Question: Draft a figure caption describing what is shown.
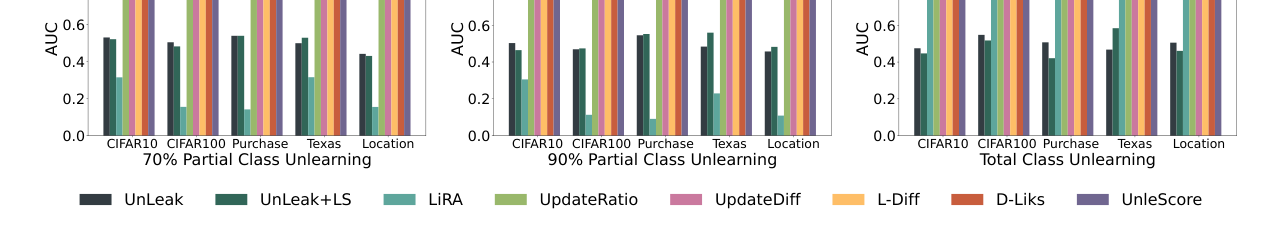
Answer: presents the summarized AUC scores for all metrics across three exact unlearning tasks applied to five datasets. Al- though LiRA, UpdateRatio, and UpdateDiff seem comparable to our designed metrics, they exhibit distinctly different score distribu- tions, as illustrated in Figure 5, and different results at lower FPR, as shown in Figure 10 and 11. Consequently, we do not regard the AUC as a meaningful statistic for evaluating these measurement results. For random sample unlearning, we further analyze TPR varia- tions as the FPR shifts from 1e-5 to 1e-1, as shown in Figure 12. On a logarithmic scale, L-Diff and D-Liks significantly outperform other baselines, particularly at lower FPRs, with minor differences between each other. Besides, the ROC curves for LiRA, UpdateRatio, and UpdateDiff align with those of L-Diff and D-Liks only after the FPR exceeds 0.5, which is a high threshold, as detailed in Fig- ure 10. Despite their relative superiority, L-Diff and D-Liks achieve a m